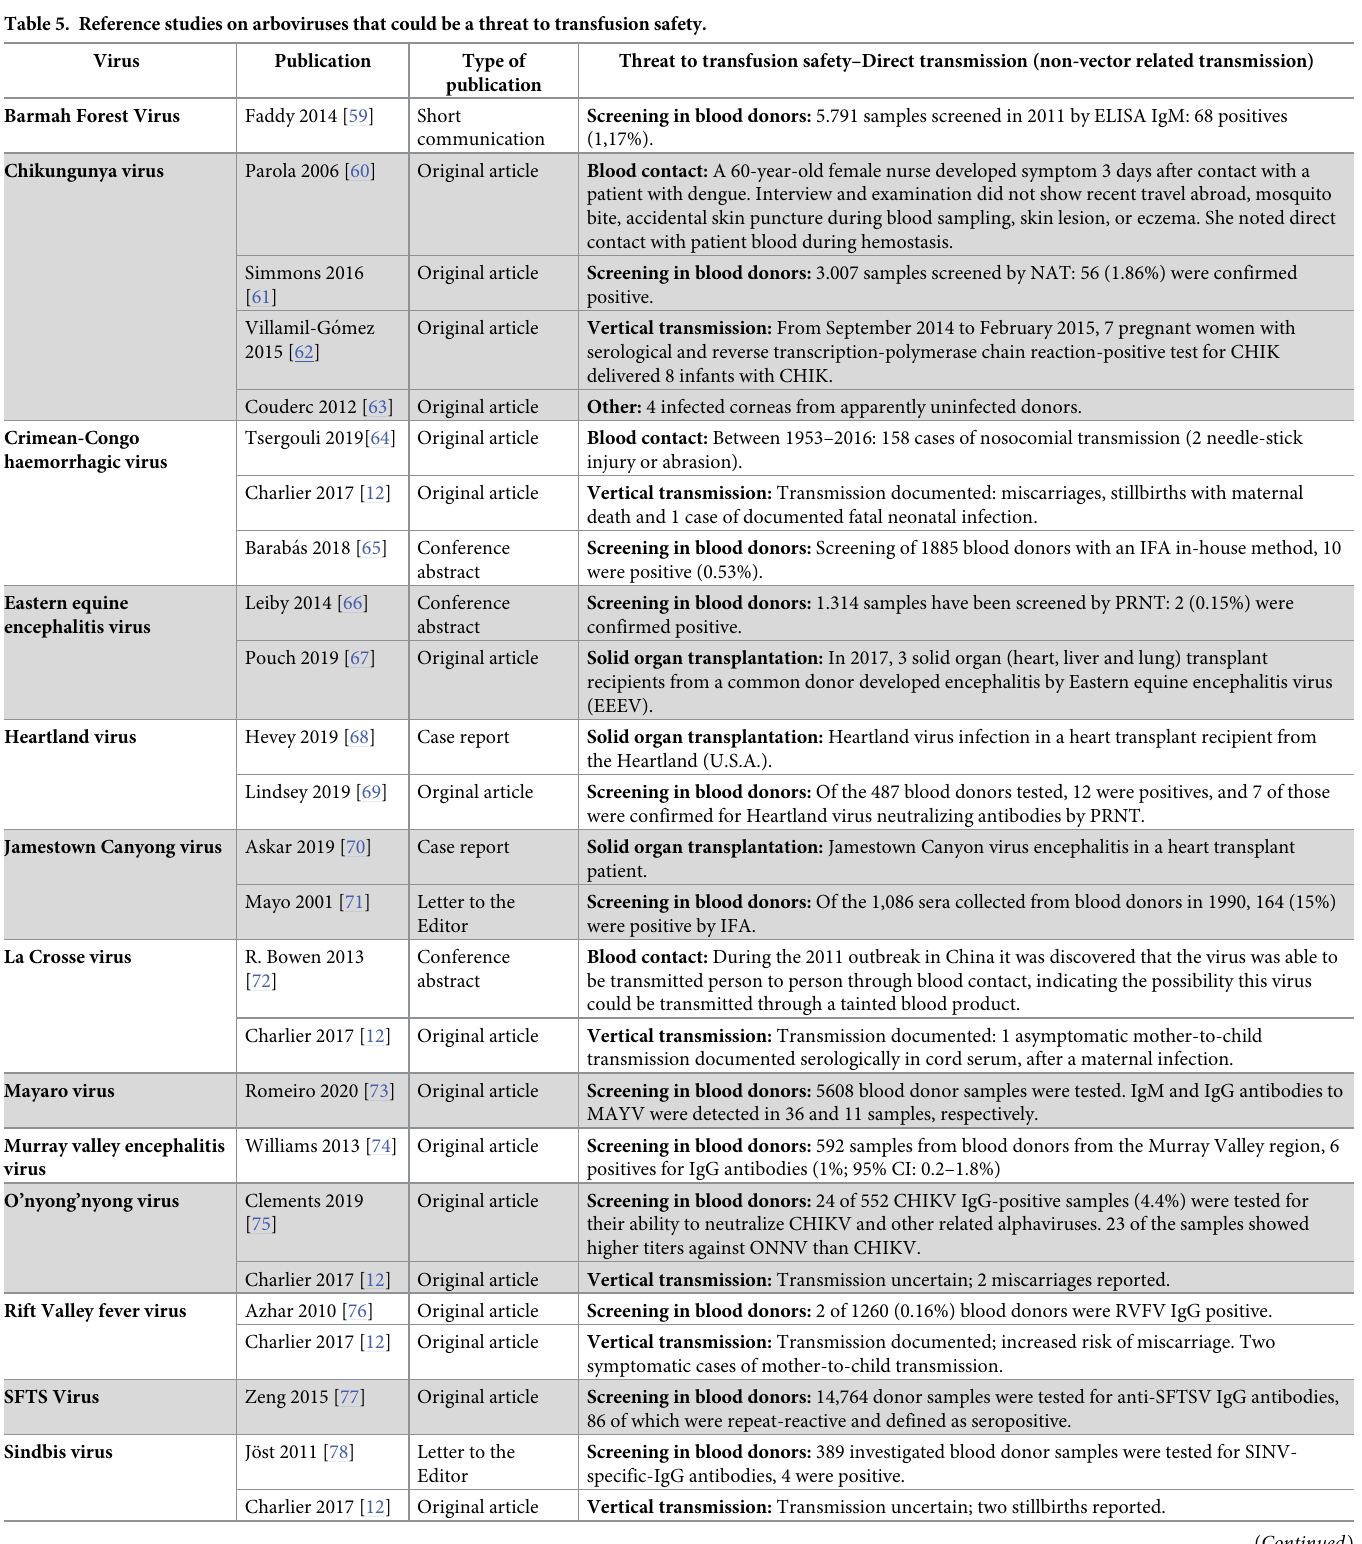
Table 5. Reference studies on arboviruses that could be a threat to transfusion safety.